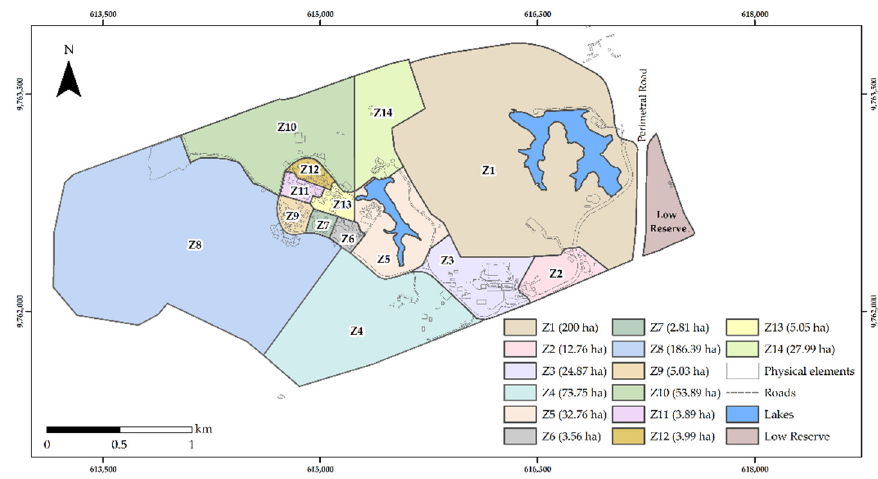
Figure 5. Zoning of ESPOL property.